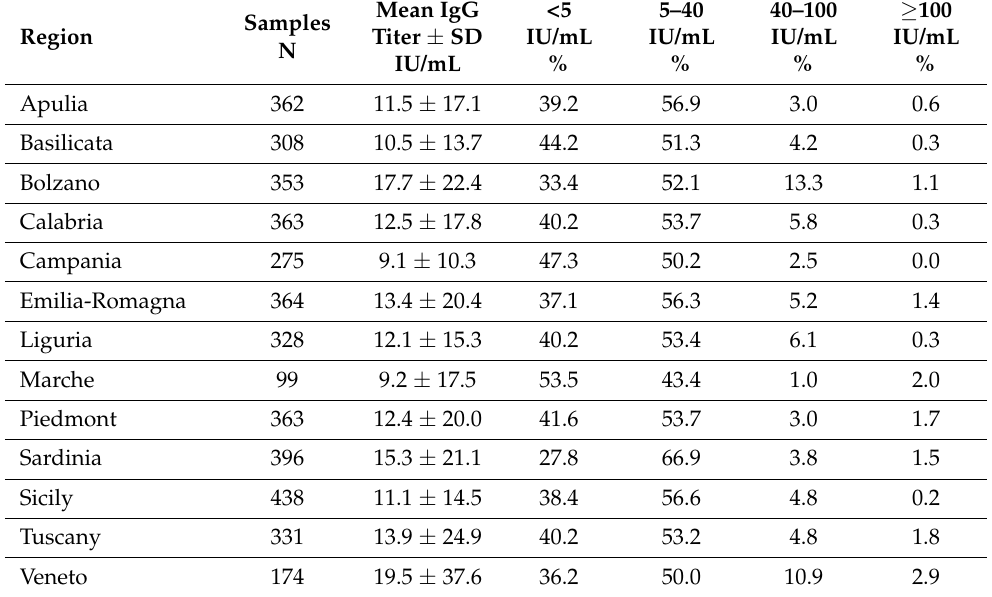
Table 2. Mean antibody titer and relative distribution (%) of the tested samples as a function of the level of anti-PTx IgG antibodies by